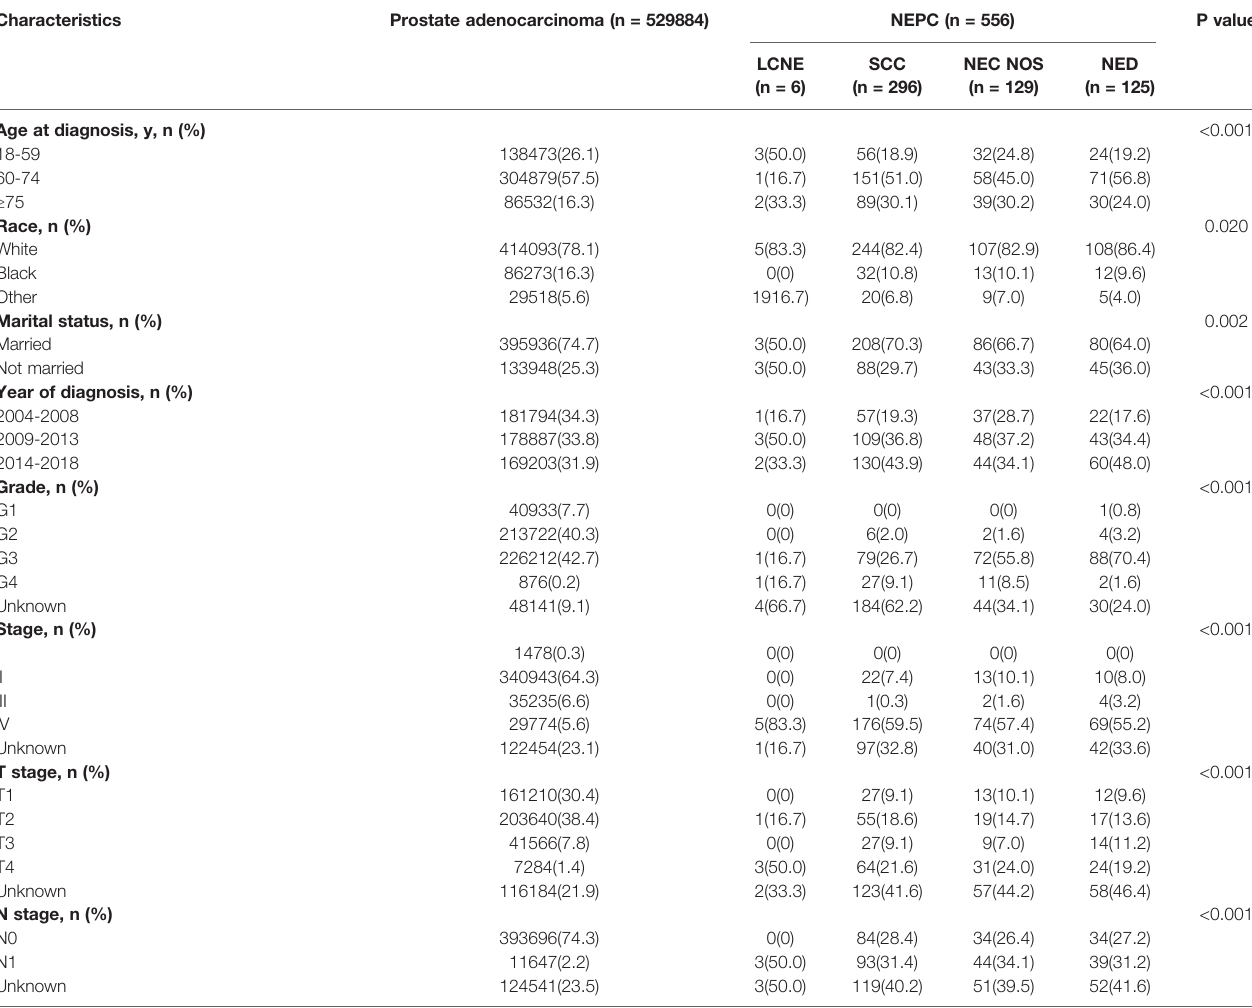
TABLE 2 | Baseline demographic and clinicopathologic characteristics of patients with prostate adenocarcinoma compare to four histological subtypes of NEPC.